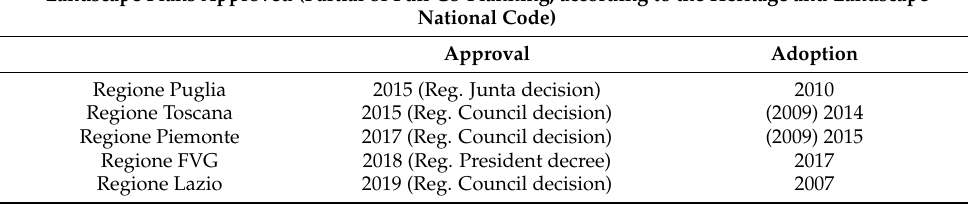
Table 1. Landscape plans in Italy, following the 2004 Code. Dates of approval and adoption. Landscape Plans Approved (Partial of Full Co-Planning, according to the Heritage and Landscape National